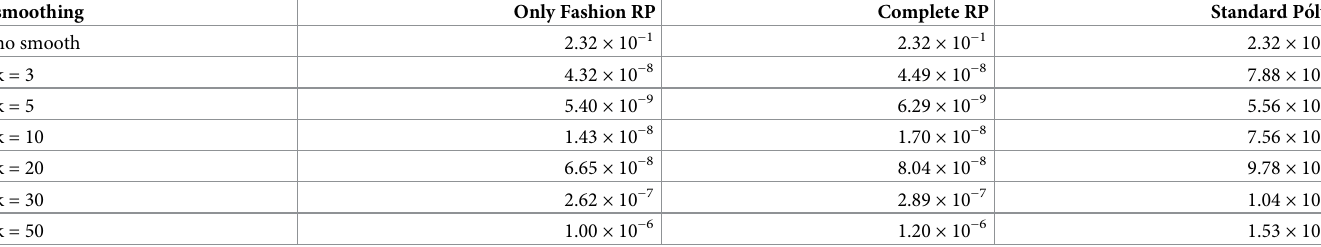
Table 18. “10 days of traffic” ( T = 0.5, entire, D = 30 00 , S = 100 slots of equal size): MSE for different levels of smoothing.